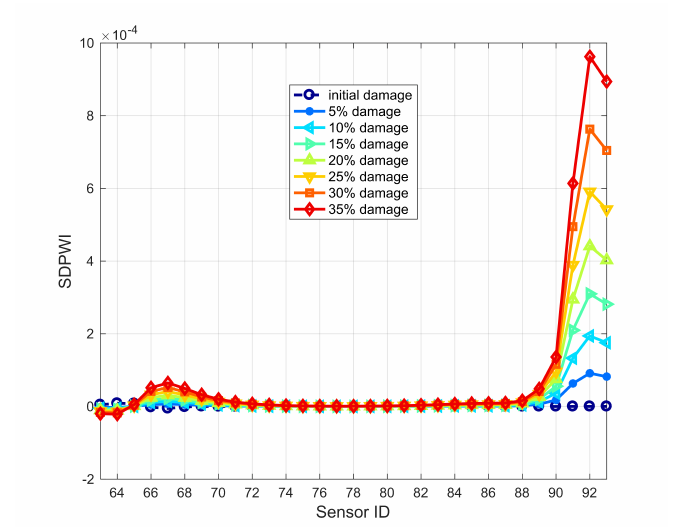
Figure 11. Damage identification results using SDPWI for Damage